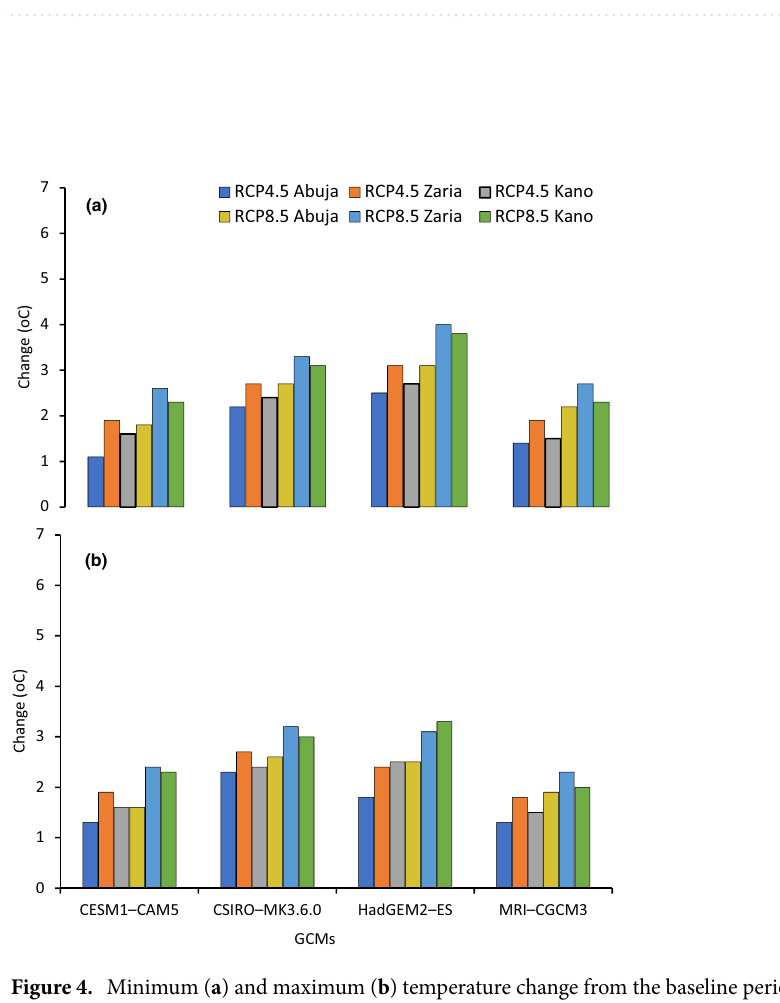
Figure 3. Thirty years seasonal minimum temperature for baseline (1980–2009) and ensemble mid–century (2040–2069) and end of century (2070–2099) periods under RCP4.5 (left) and RCP8.5 (right) in SGS, NGS and SS. Extremes on whiskers (two lines outside the box) encompass the range between lowest and highest values, the box spans the interquartile range, extremes of the box encompass the range between the 25 and 75% quartiles, and the horizontal line within each box section shows the median. Circles located outside the whiskers referred to as outliers.